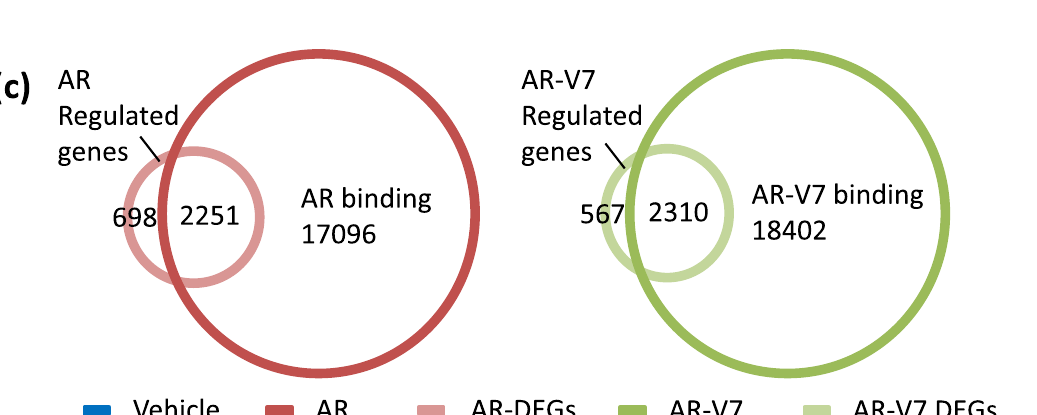
nizes the C-terminus of AR and thus only full-length AR. R1881 dependent recruitment is detected at the same sites as when the Active Motif antibody is used (Fig. 4d-h). When the signal in response to AR-V7 induction